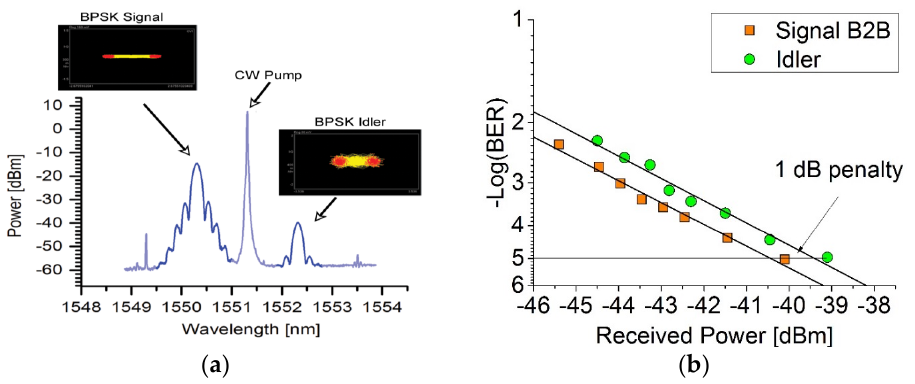
Figure 5. ( a ) Output DPSK (Differential Phase Shift Keying) spectra (resolution 0.05 nm) recorded at